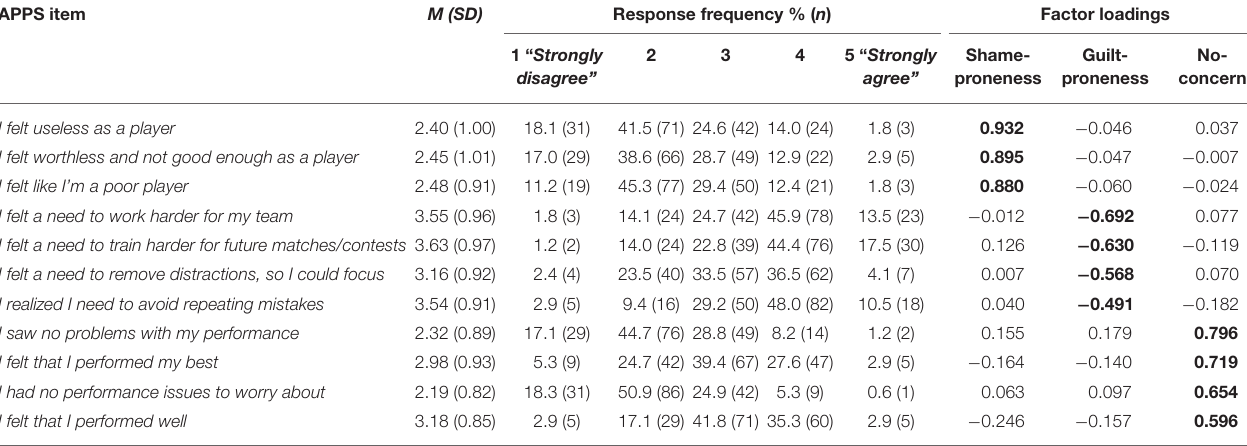
TABLE 2 | APPS descriptive statistics and factor